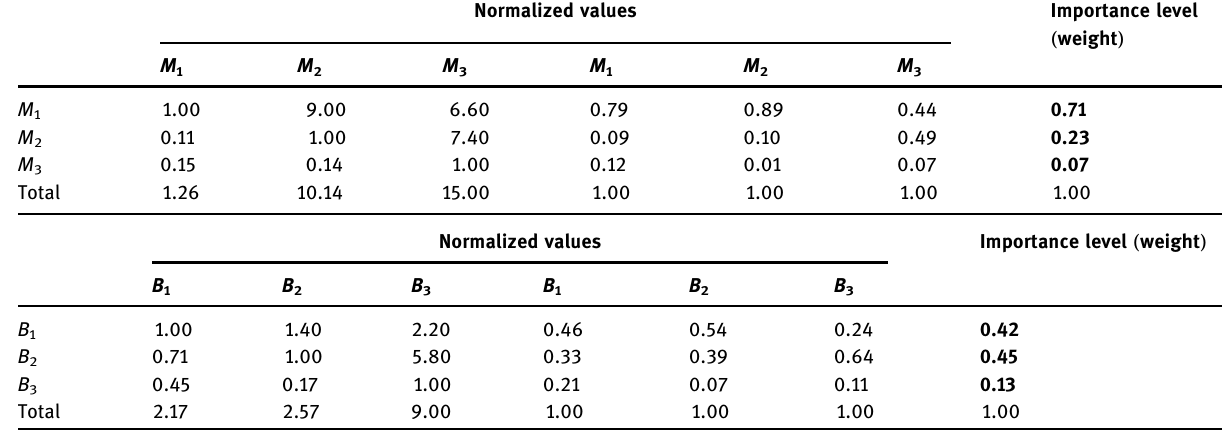
Table 7: Determining the importance level ( weight ) of internal risks Normalized values Importance level